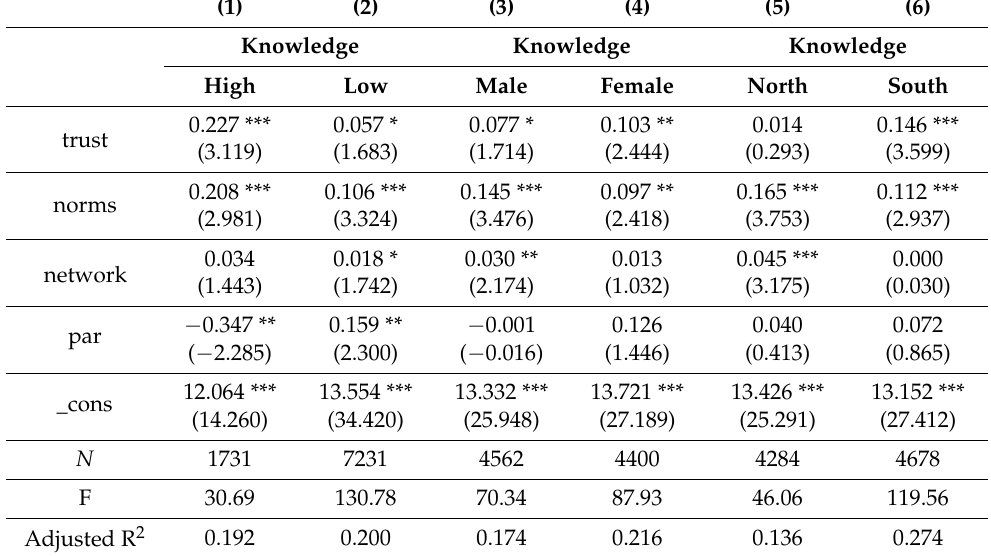
Table 9. Heterogeneity